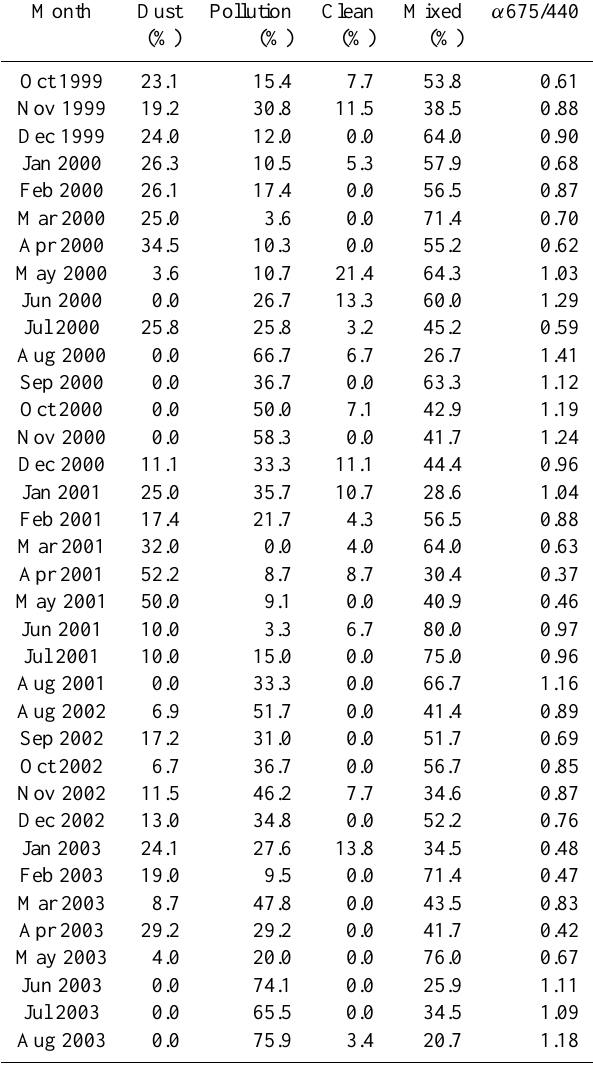
Table 1. Percentages of occurrence for different aerosol categories and their corresponding ˚Angstr¨om